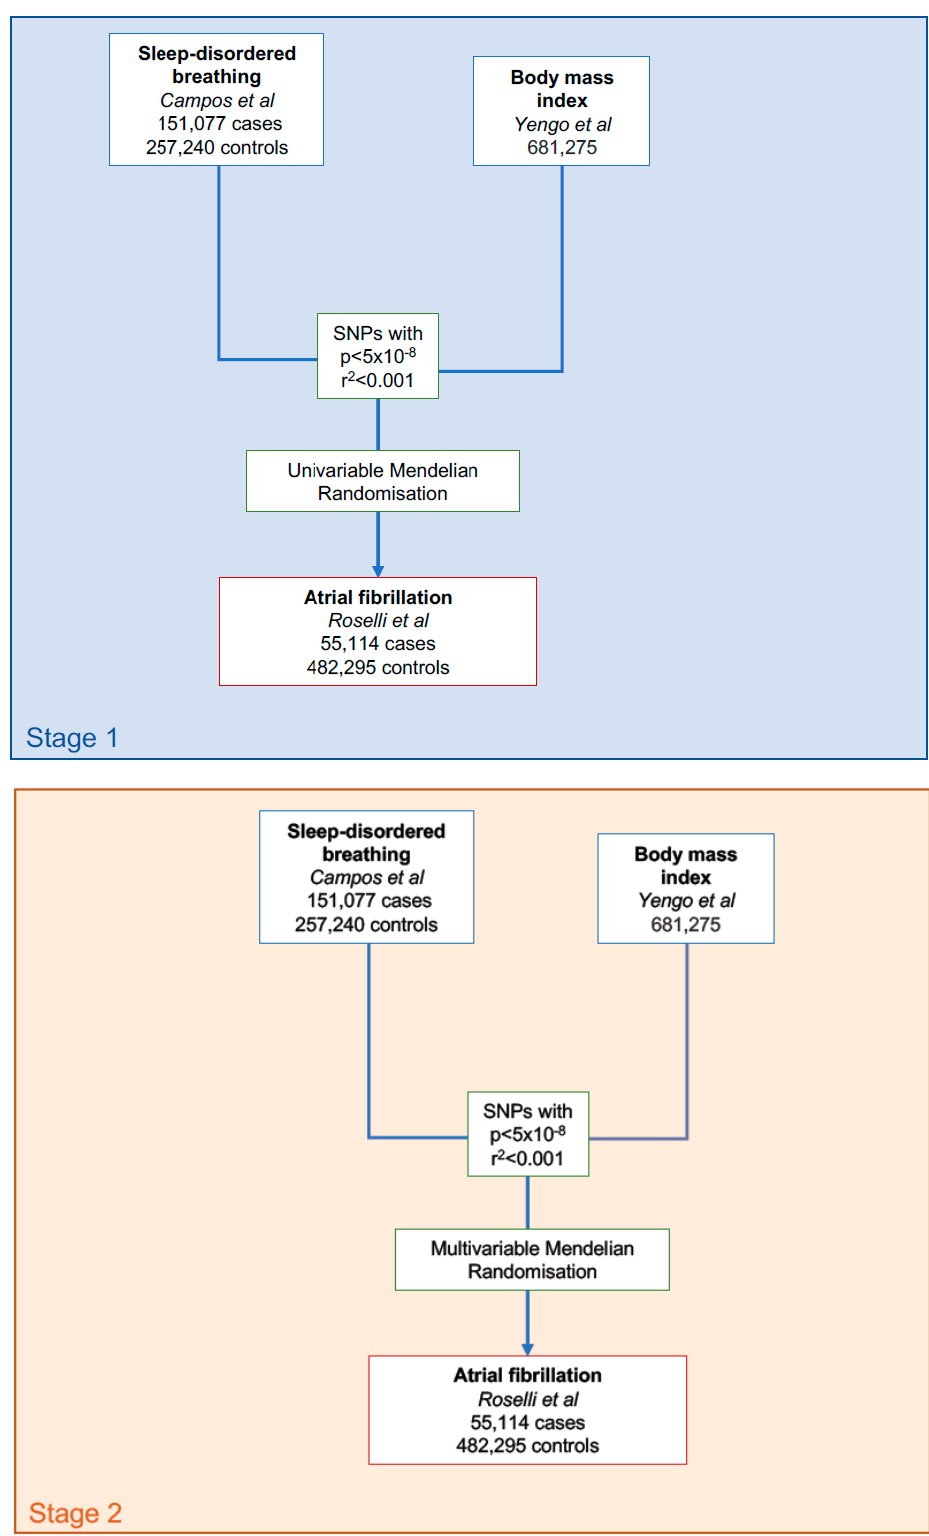
Figure 1. Data acquisition and statistical analysis flowchart.